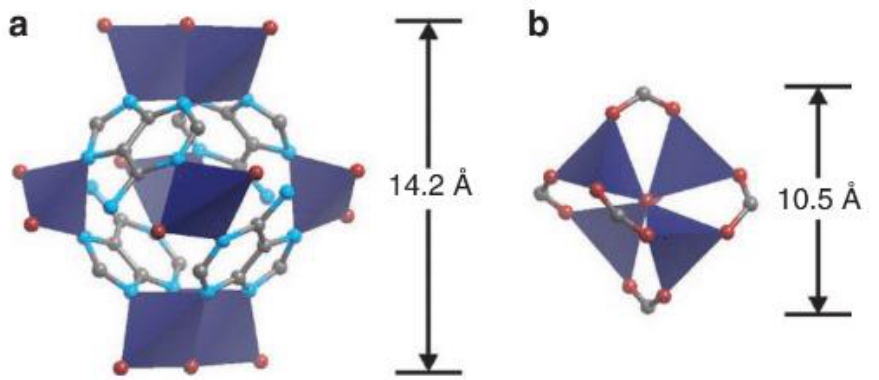
Figure 2. Comparison of ZABU ( a ) and zinc acetate ( b ) secondary building units. (Zn 2+ , dark blue tetrahedra, C, grey, O, red, N, blue, H omitted for clarity) [122]. Adapted from ref. [122] with permis- sion.